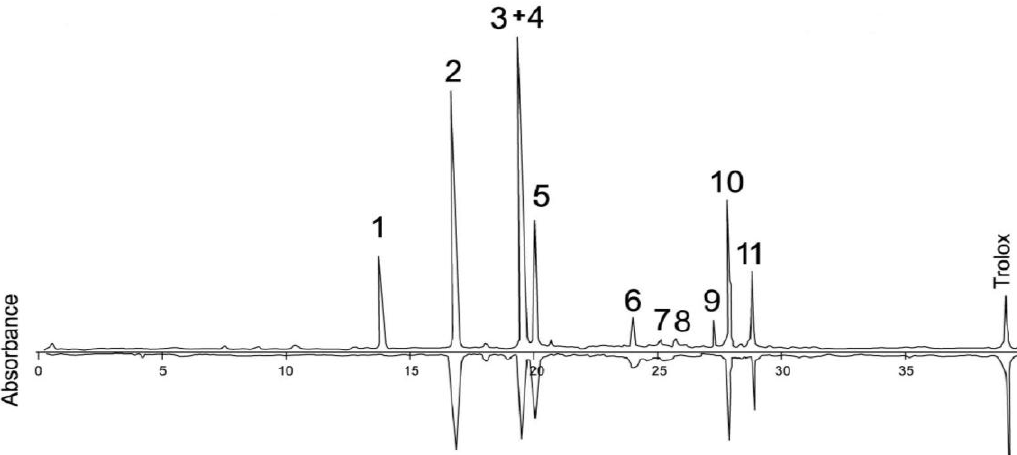
Figure 2. On-line HPLC ABTS + analysis of the Ilex paraguarienses beverage chimarrão (sample S2). Positive Trace: PDA at 280 nm and Negative Trace: UV-VIS at 600 nm. Peak identification: 1, caffeine; 2, 3- O -caffeoylquinic acid; 3, 5- O -caffeoylquinic acid; 4, teobromine; 5, 4- O -caffeoylquinic acid; 6, quercetin-3-rhamnosylglucoside; 7, quercetin- 3- O -glucoside; 8, kaempferol-3- O -glucoside; 9, 3,5-dicaffeoylquinic acid; 10,